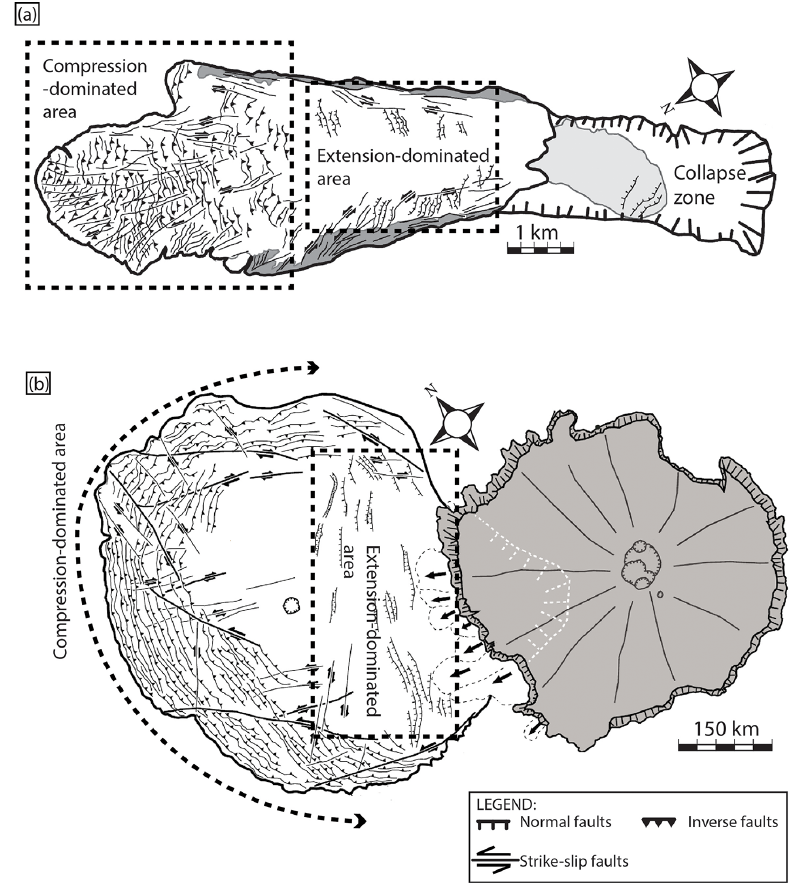
Figure 1. (a) Blackhawk deposit and (b) Martian deposit (modified after Shea and van Wyk de Vries, 2008).